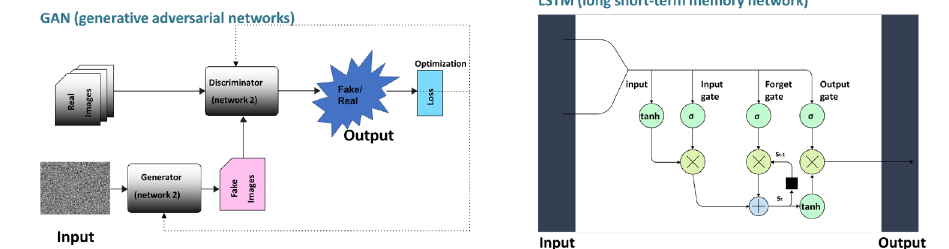
Figure 3. Conceptual diagram of GAN and